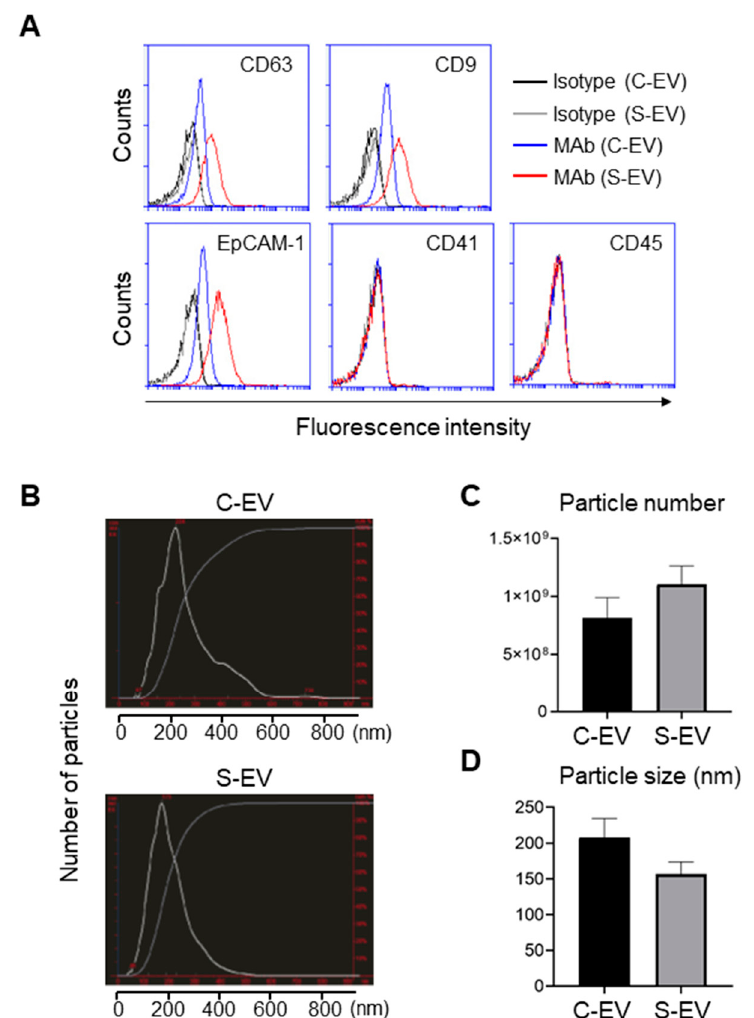
Figure 1. Characterization of EVs isolated from luminal washes in large intestines of control and septic mice. ( A ) Flow cytometry analysis of EVs isolated from luminal washes in large intestines of control and sepsis mice. EVs were isolated by differential UC and adsorbed on 4 μ m poly-L-lysine microbeads overnight. Immobilized EVs (20 μ g) were stained with indicated monoclonal antibodies (MAb) and subjected to flow cytometry to evaluate their expression. Representative histograms show changes in expression of indicated marker. Black line, isotype (C-EV); gray line, isotype (S-EV); blue line, MAb (C-EV); and red line, MAb (S-EV). ( B ) Representative NanoSight LM10 images showing sizes of EVs from control (top) and septic (down) mice. ( C ) Particle number of EVs as quantified by NTA. ( D ) Size distribution of gut- derived C-EVs ( N = 15) and S-EVs ( N = 16) mice groups as measured by dynamic light scattering (DLS) device. C-EV, control extracellular vesicle; and S-EV, sepsis extracellular vesicle.